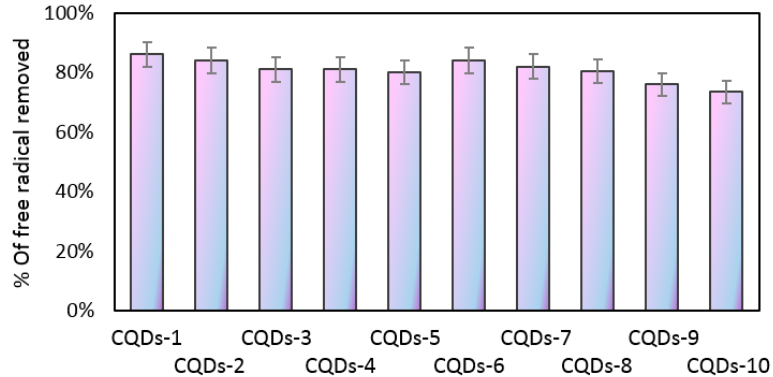
Figure 9. Antioxidant properties of the prepared CQDs against DPPH radicals.